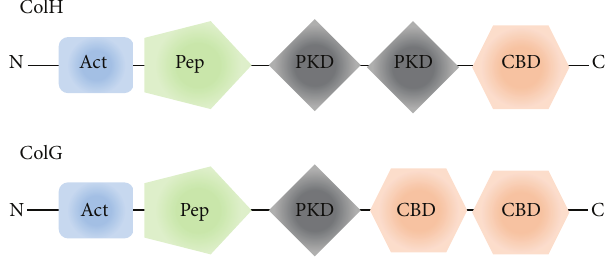
Figure 1: Schematic diagram of the domain architectures of ColG and ColH. Act: activator domain; Pep: peptidase domain; PKD:polycystickidneydisease-likedomain;CBD:collagen-binding domain. The collagenase module is composed of two functional domains, an activator domain and a peptidase